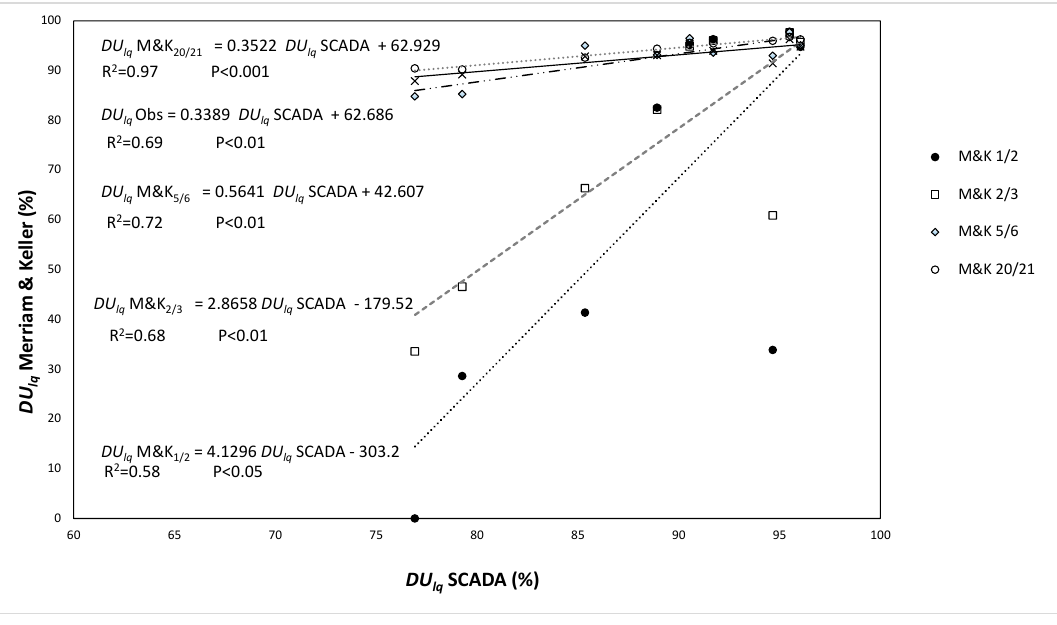
Figure 7. Relationship between DU lq SCADA and DU lq using Merriam and Keller method taking different end emitters, and DU lq for all emitters (Observed).